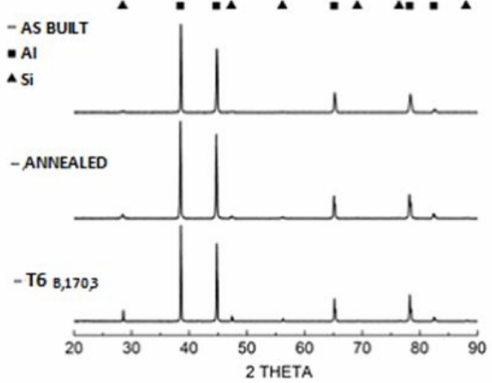
Figure 5. FESEM images of A357 samples: ( a ) as-built; ( b ) after stress-relieving; ( c ) after T6 B,170,3 heat treatment. The white arrow indicates building direction.